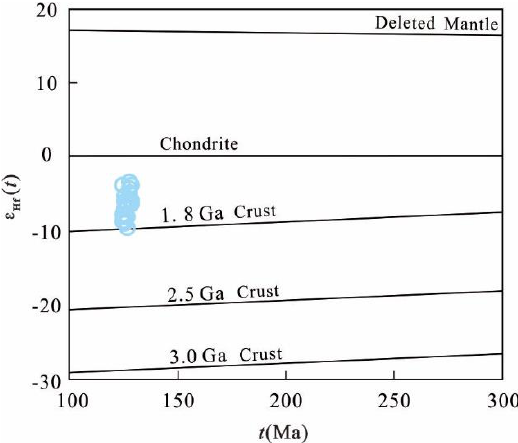
Figure 8. The diagrams of t - ε Hf (t) of the Jinling complex pluton.